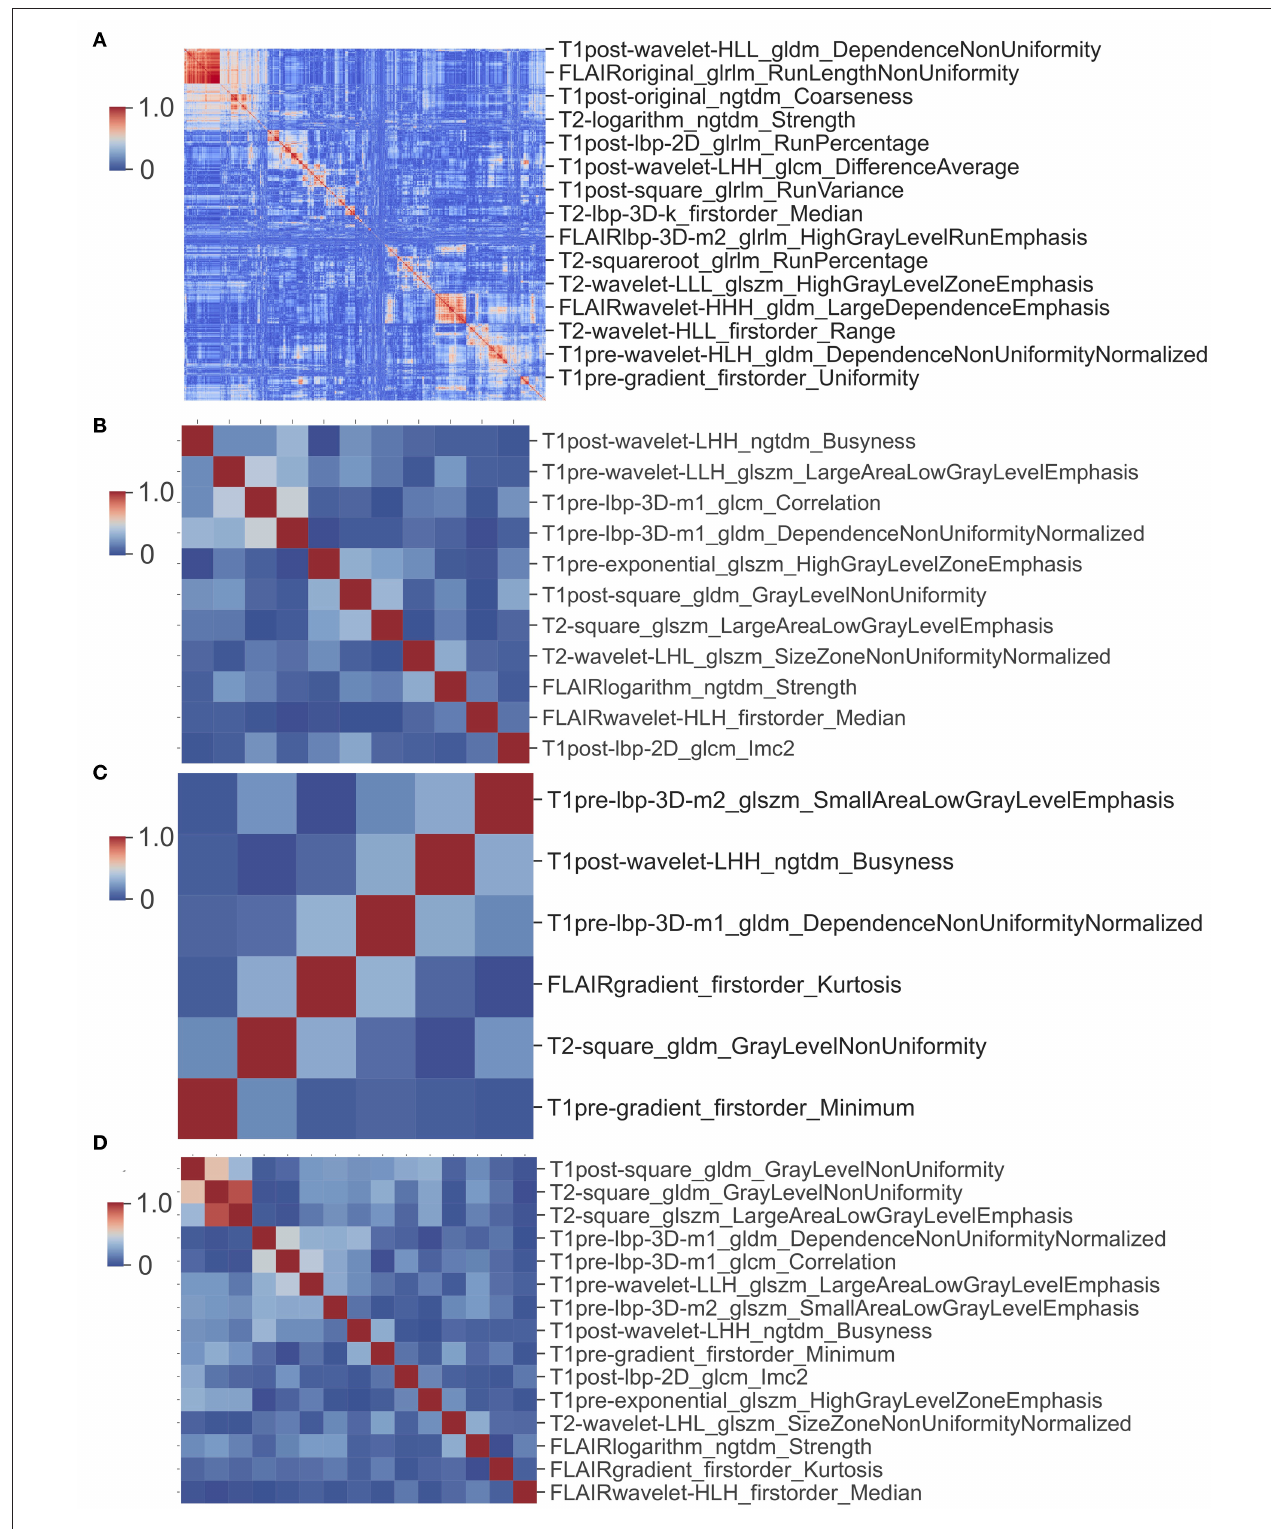
FIGURE 6 | Cluster map of correlation between image features. (A) Cluster map of correlation of 6,676 image features. (B) Cluster map of correlation of 11 features used in glioma CIC mutation prediction model. (C) Cluster map of correlation of six features used in oligodendroglioma CIC mutation prediction model. (D) Cluster map of correlation between 15 image features from (B) and (C)